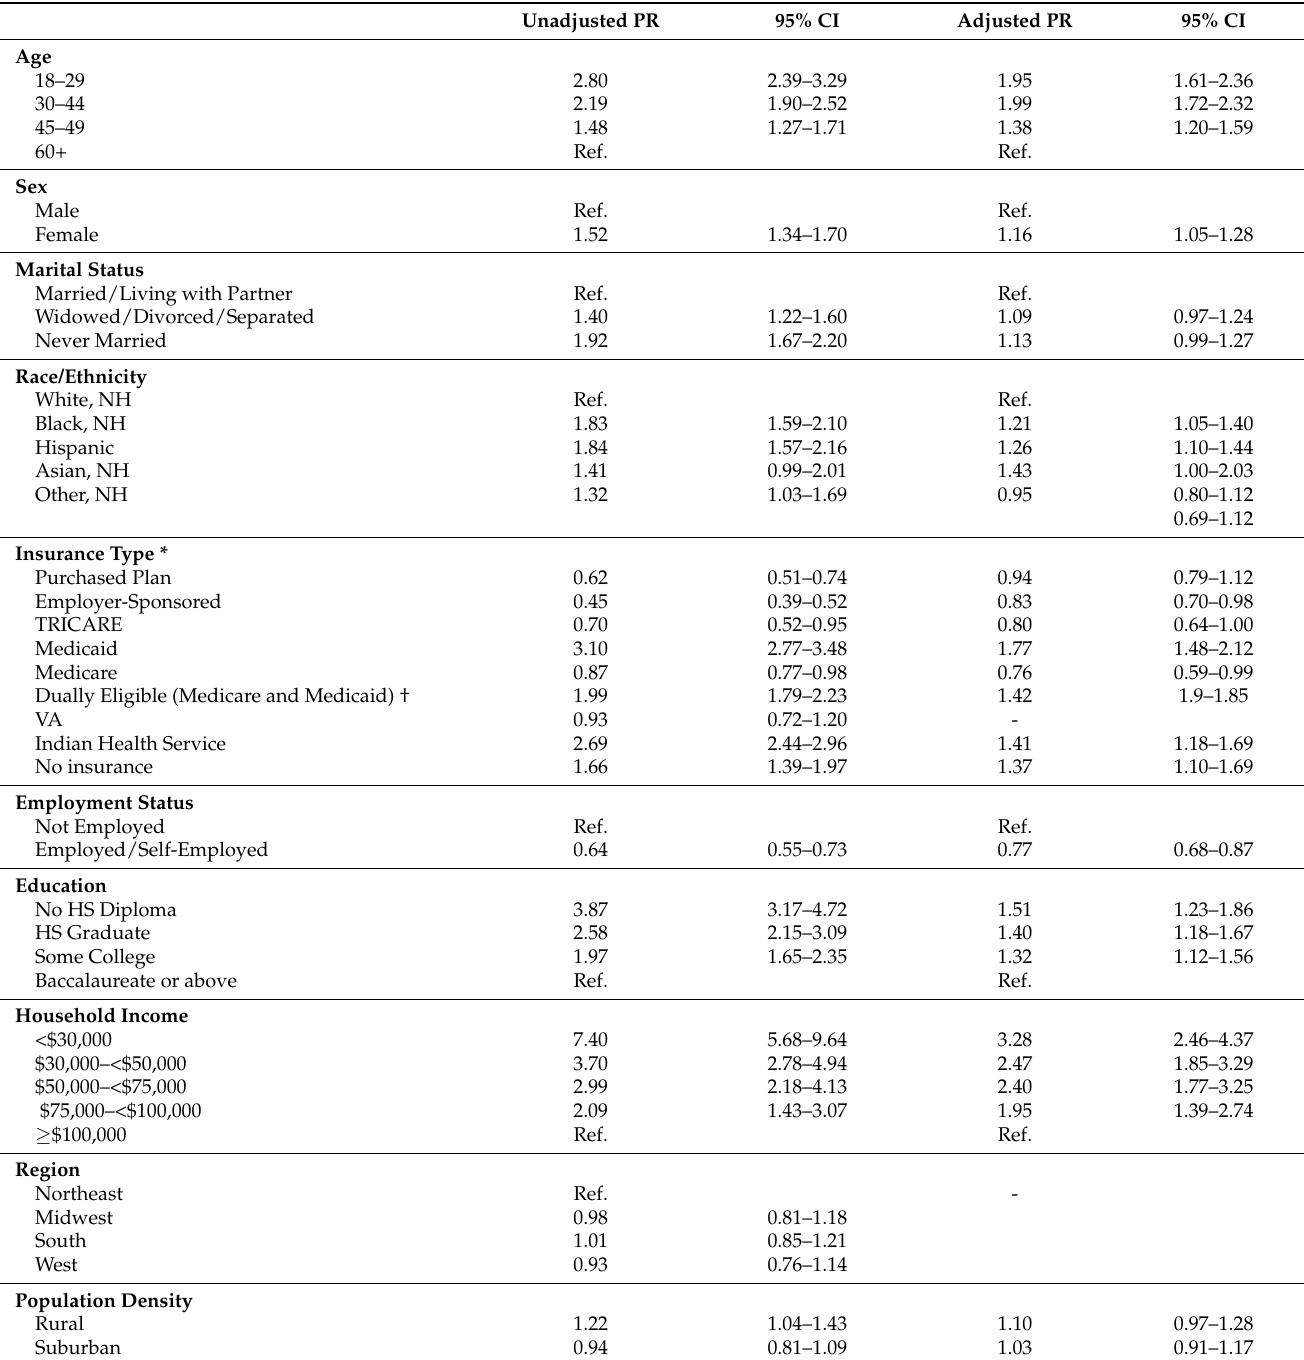
Table 3. Determinants of food insecurity among adults with cardiometabolic conditions in the